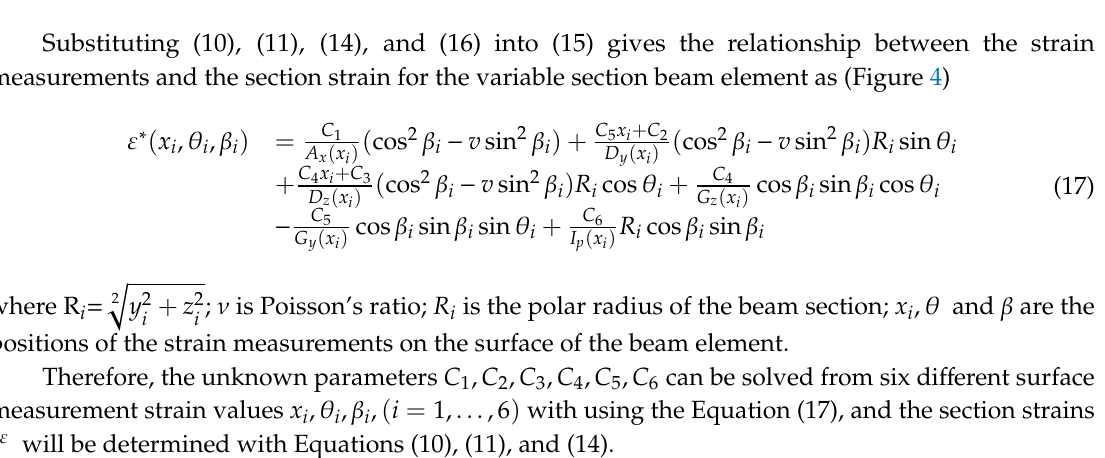
Figure 4. Location and coordinate system of a FBG sensor placed on the wing external